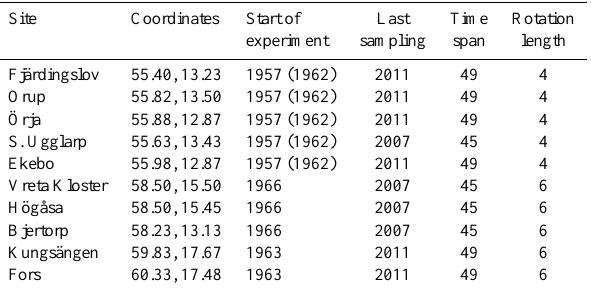
Table 1. The 10 experimental sites used in this study with coor- dinates ( ◦ N, ◦ E), starting year (in brackets: starting year in this study), year of last sampling, time span between first and last sam- pling (years) and length of the rotation (years).